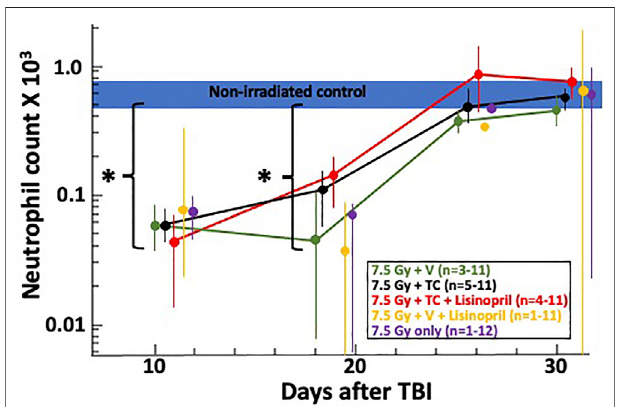
FIGURE3| Neutrophilrecoverythrough30-dayspost7.5 Gytotalbody irradiation (TBI) is shown on a log-scale for the neutrophil count ( × 10 3 ). The horizontal blue bar represents the neutrophil counts for non-irradiated controls. Asterisks (*) represent p < 0.02 as compared to non-irradiated controls. At 18 days, the two irradiated groups given the triple combination (TC, consisting of PEG-hG-CSF, PEG mGM-CSF and PEG hIL-11) with (red) and without lisinopril (black), had higher neutrophil counts ( p ≤ 0.005) than the irradiated groups given the vehicle and lisinopril (yellow). Neutrophil counts returned to levels resembling non-irradiated controls by 25-days post- irradiation. The “ n ” values represent the number of rats alive in each group between 10 and 30 days after irradiation which decreased over time due to rats becoming moribund. Error bars represent 95% CIs for the mean.